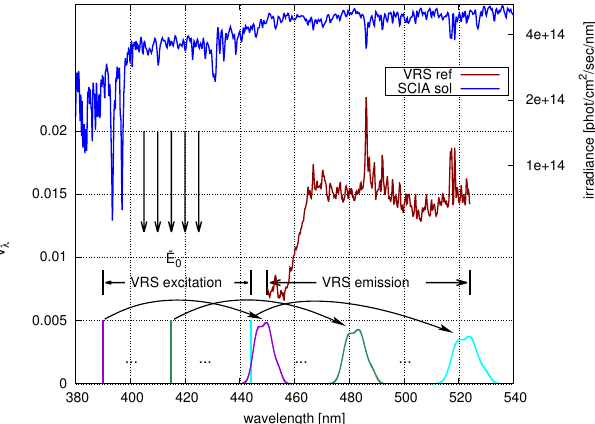
Figure 1. Incoming extraterrestrial solar irradiance spectrum (blue), as measured by the SCIAMACHY satellite sensor. Incoming radia- tion in the VRS excitation wavelength region (390–444.5nm) leads to a filling-in in the VRS emission wavelength region (450–524nm) as calculated with SCIATRAN (brown) according to Eq. (9). For three specific excitation wavelengths, their appropriate redistribu- tions in the emission range are shown (in magenta, green, and cyan). The jump of the solar spectrum between 390 and 400nm leads to an equivalent jump in the VRS spectrum at 445 to